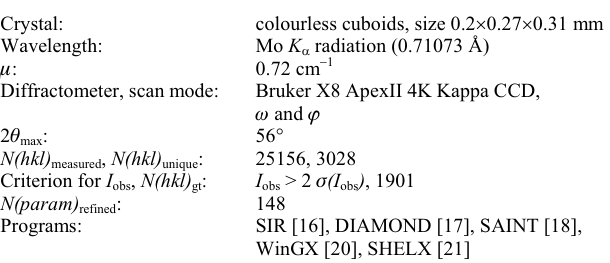
Table 1. Data collection and handling.